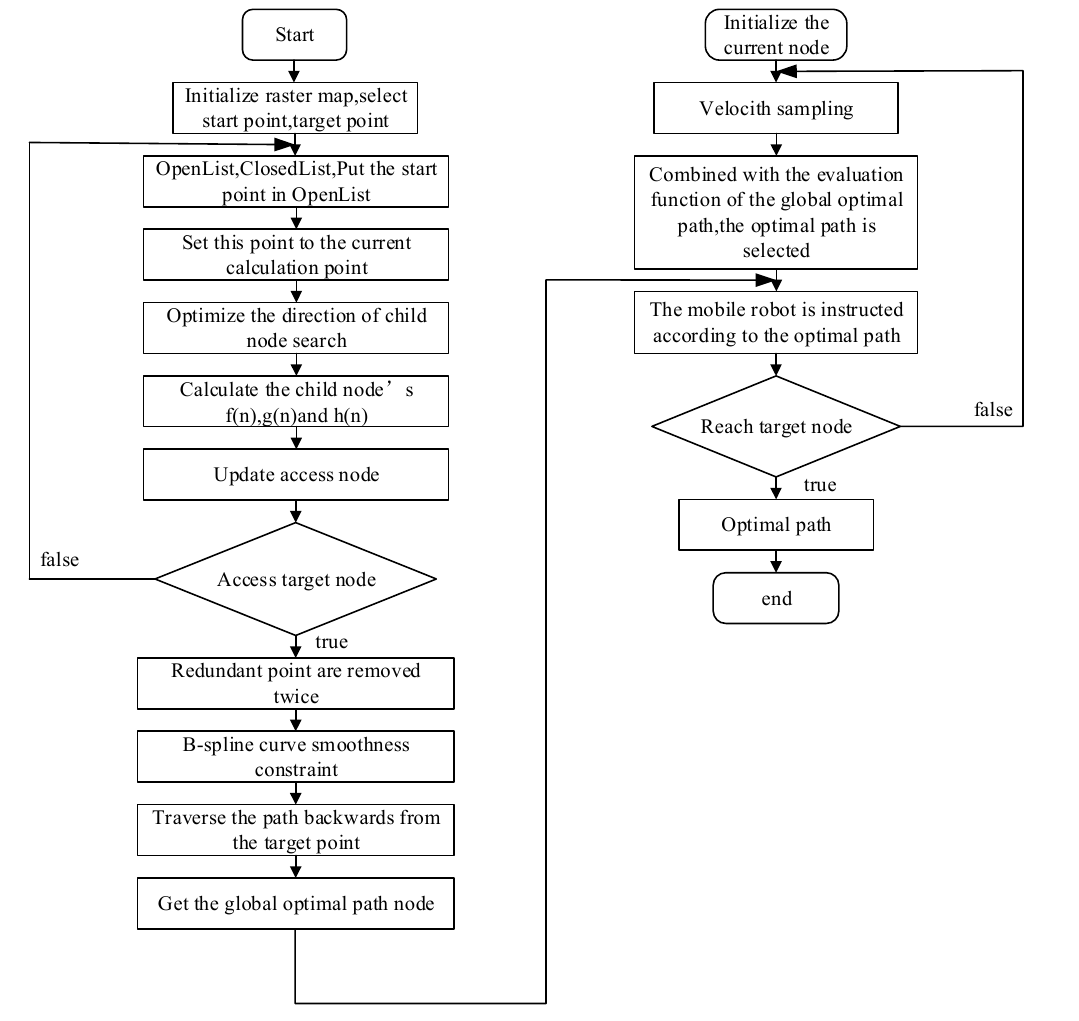
Figure 5. Fusion algorithm fl ow chart.